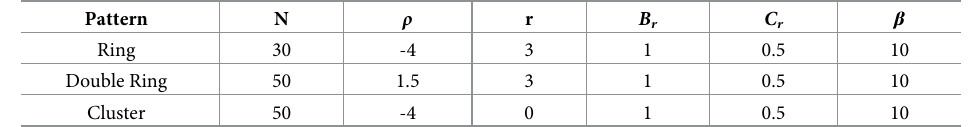
Table 5. Multi-agent behaviors